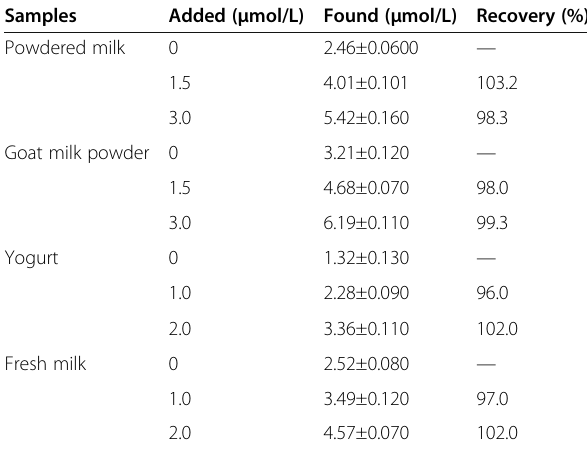
Table 2 Results of the determination of Tyr in milk and its product samples